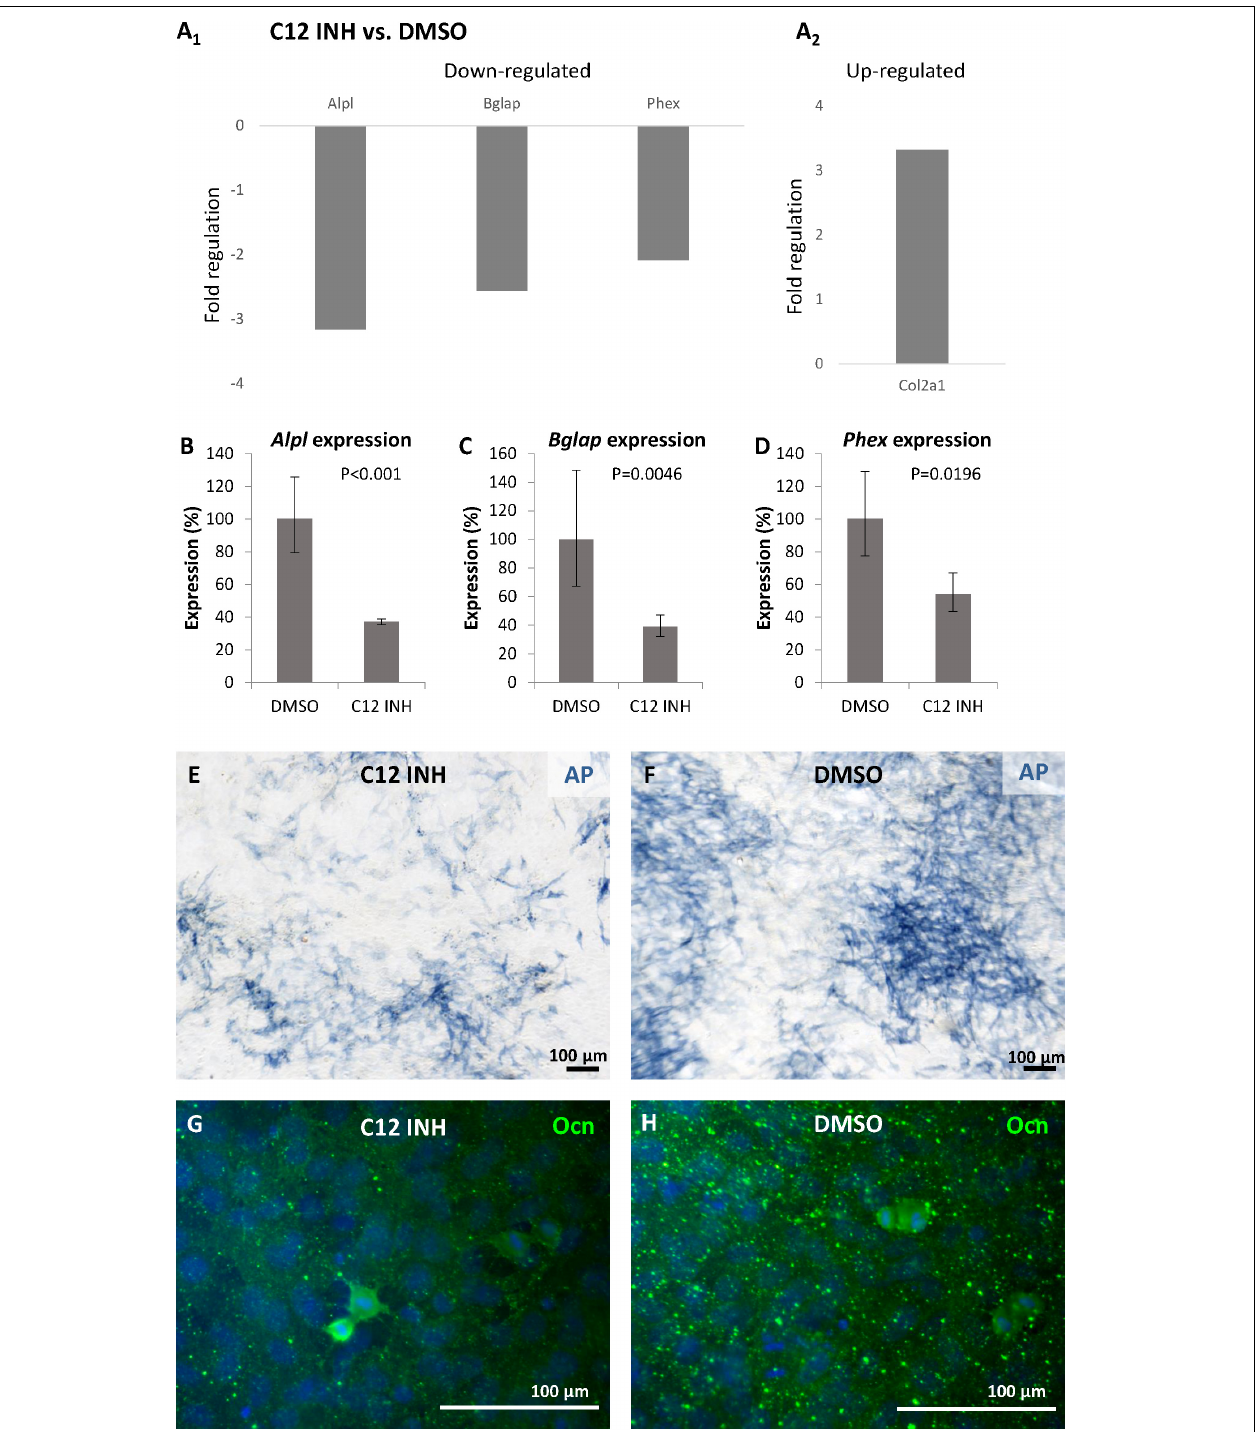
FIGURE 5 | Inhibition of caspase-12 in MC3T3-E1 cells. Changes in gene expression of osteogenesis-related genes (A 1 , 2 ) in differentiated MC3T3-E1 cells after inhibition of caspase-12 by the specific inhibitor Z-ATAD-FMK, and DMSO-treated cells used as a control. Analysis shows fold regulations (–2/+2 is used as the threshold) of gene expression, statistically significant ( P < 0.05) changes are displayed. Real-time PCR confirmed statistically significant decrease of Alpl (B) , Bglap (C) , and Phex (D) in inhibited MC3T3-E1. Results are presented as means ± standard deviations and were analyzed using two-tailed t -test. Staining for activation of alkaline phosphatase (blue) in MC3T3-E1 cells after caspase-12 inhibition (E) compared to control (F) . Immunofluorescence staining of osteocalcin expression (green) in differentiated MC3T3-E1 after inhibition of caspase-12 (G) compared to control (H) . Scale bar: 100 µ m, counterstained by DAPI (blue).